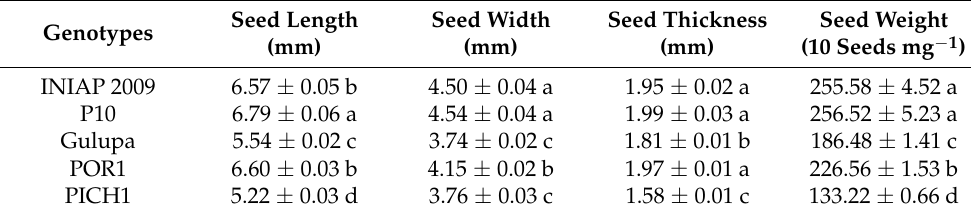
Table 1. Seed traits for each genotype of passion